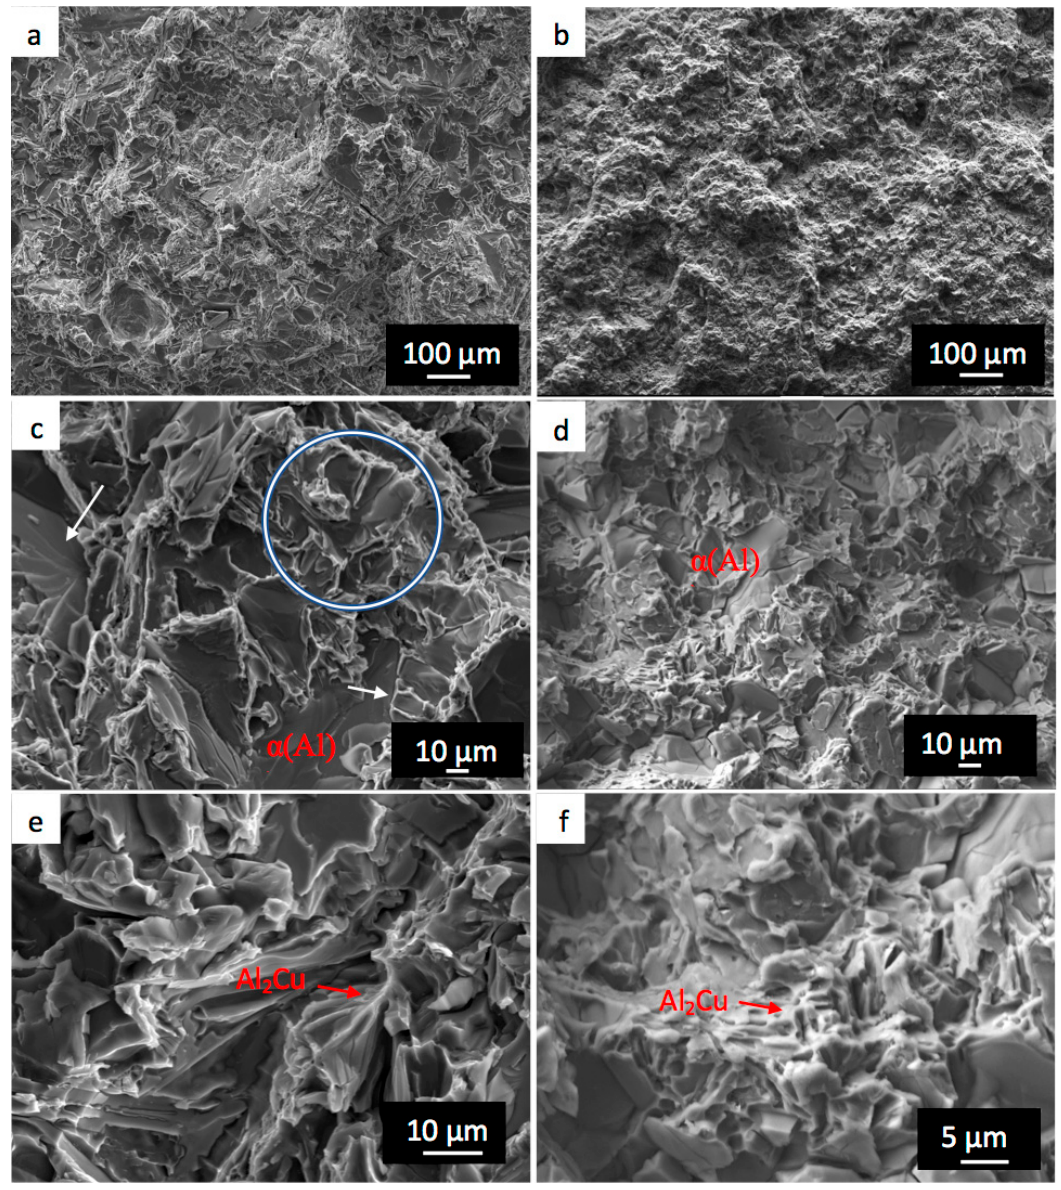
Figure 8. Fracture surfaces of Al-18%Si-2%Cu alloy ( a , c , e ) conventionally cast and ( b , d , f ) rapidly quenched.